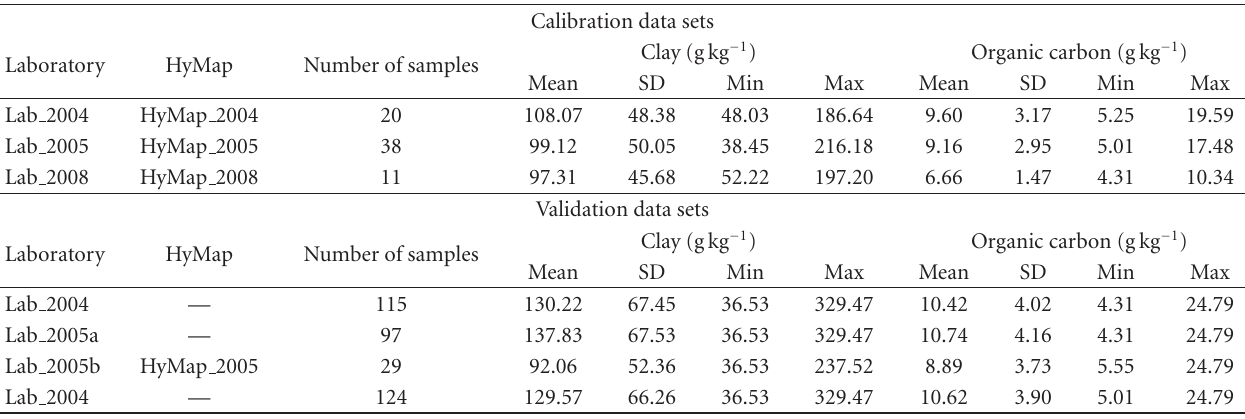
Table 4: Descriptive statistics of the calibration and validation data sets for the prediction of clay and organic carbon content with laboratory and HyMap image spectra.